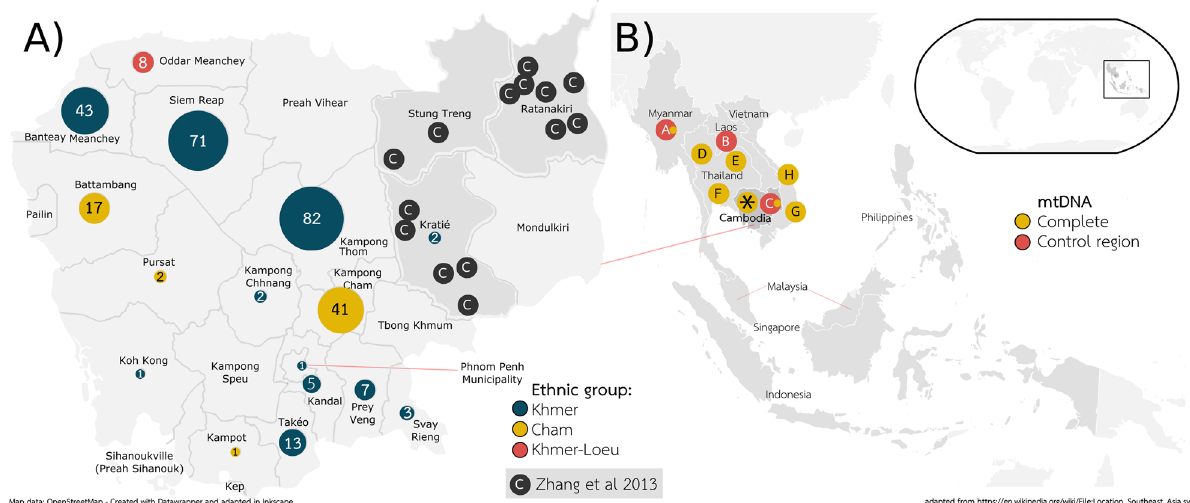
Figure 1. ( A ) Places of birth of samples from three different ethnic groups (Khmer, Cham, Khmer-Loeu). Additionally, the sampling locations of Zhang et al. are represented, thereby outlining the lack of Cambodian samples. ( B ) Schematic representation of data sets analysed, letters A–H representing publications with the colour denoting the completeness of the mtDNA sequences (yellow = complete, red = control region (CR) sequences). A = Summerer et al. (327 CR, 44 full) 18 , B = Bodner et al. 16 (214 CR), C = Zhang et al. (1,054 CR, 98 full) 2 , D = Kutanan et al. (1,234 full) 10 , E = Kutanan et al. (560 full) 12 , F = Kutanan et al. (415 full) 11 , H = Duong et al. (609 full) 14 , G = 1000 Genome samples from Vietnam (KHV. 99 full). The asterisk (*) represents